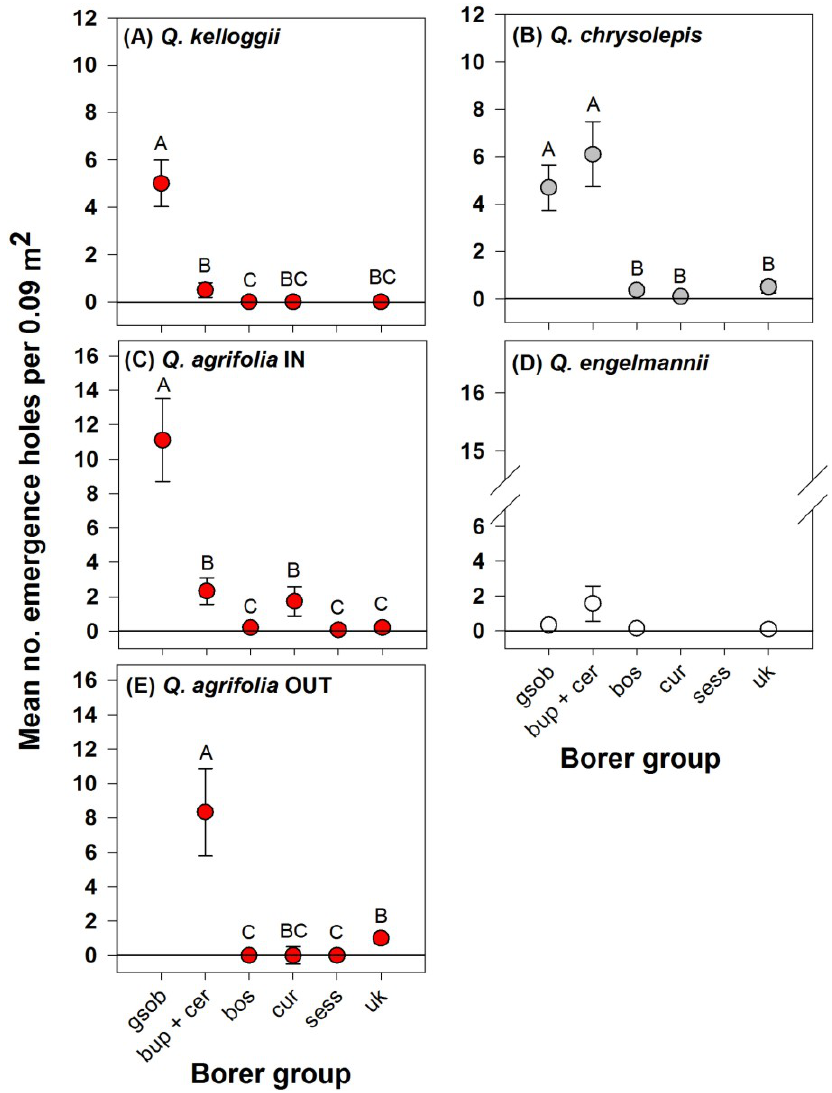
At sites in CA where pairs of oak species co-occurred, A. auroguttatus density was significantly greater than the density of other borer groups on the lower boles of Q. kelloggii ( F = 27.47; df = 4, 45; p < 0.001; Figure 2A) and Q. agrifolia within the current zone of infestation ( F = 26.84; df = 5, 54; p < 0.001; Figure 2C). Bup + cer density was also relatively high on the lower bole of CA oaks. Bup + cer and A. auroguttatus densities were greater than density of other borer groups on Q. chrysolepis ( F = 30.51; df = 4, 45; p < 0.001; Figure 2B). Bup + cer density was greater